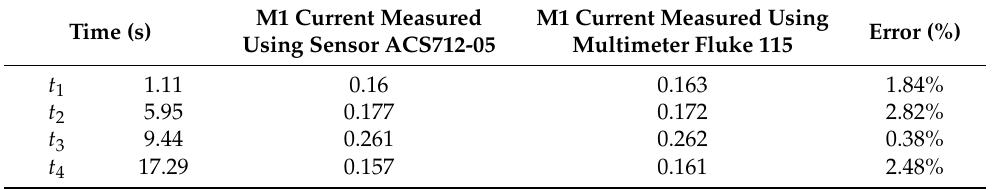
Table 6. Values obtained experimentally with the current sensor and the multimeter for motor